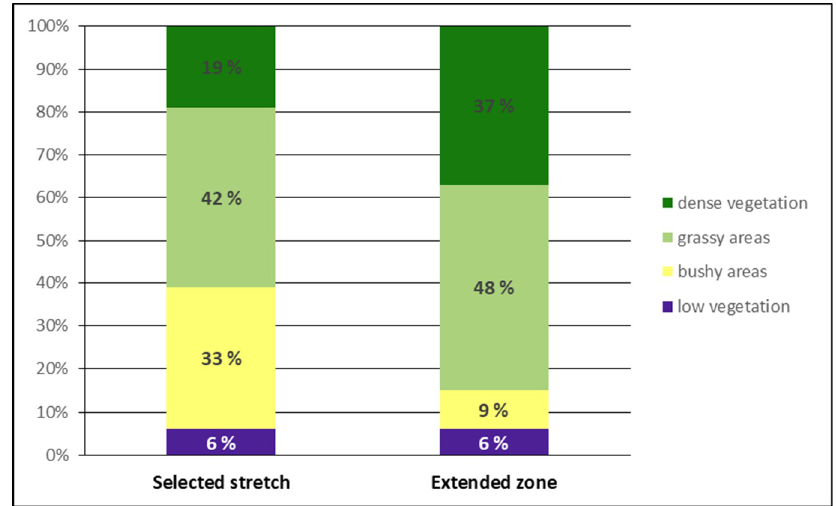
Figure 12. Distribution of vegetation types (% of pixels): comparison between the selected stretch of the drove road and in the extended zone.